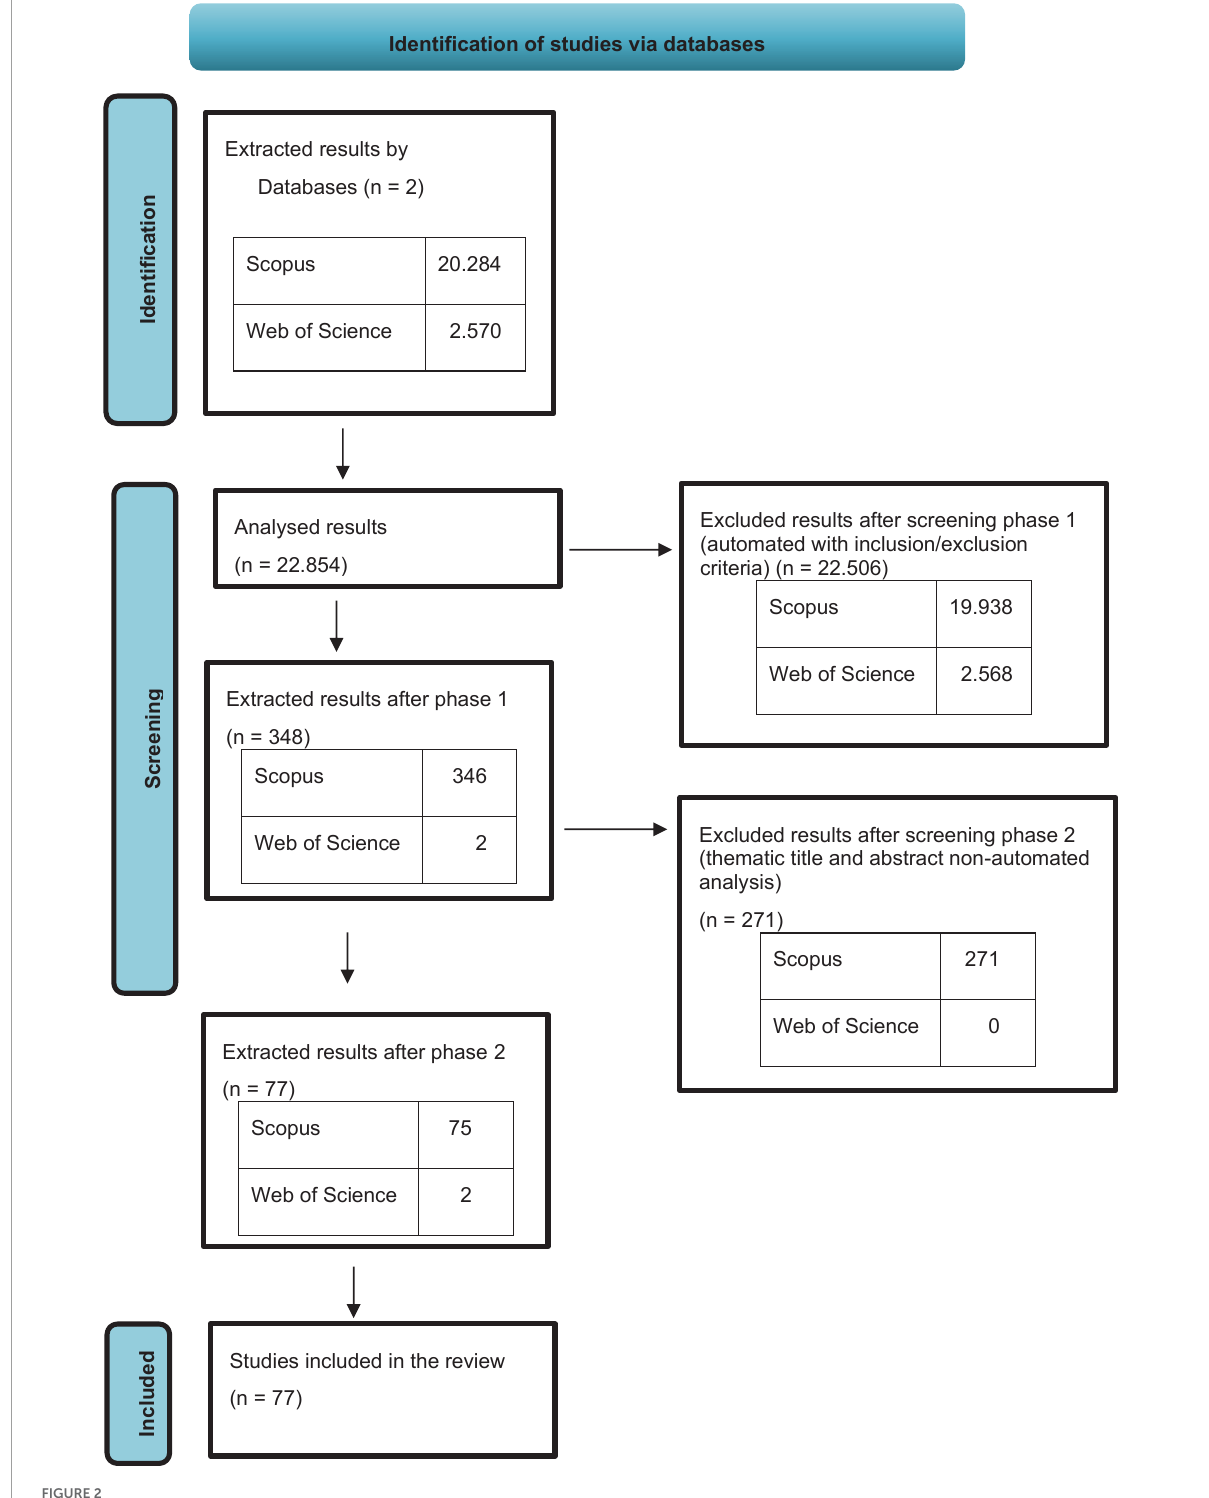
FIGURE2 Review process PRISMA (Preferred Reporting Items for Systematic Reviews and Meta-Analyses) (Page et al.,